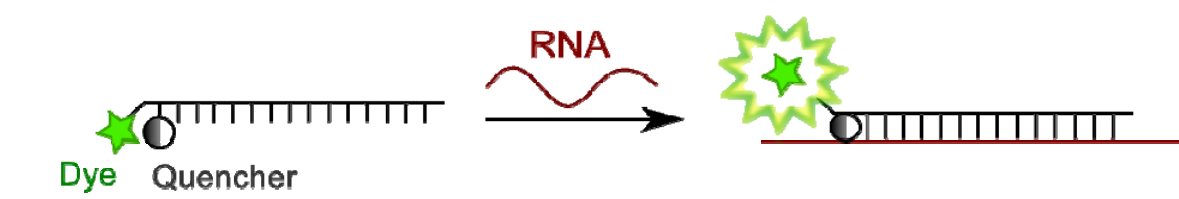
Figure 12. Linear complementary fluorescent probe with fluorophore and quencher at the 5'-terminus. When the quencher intercalates into duplex formed upon hybridization, the fluorescence appears